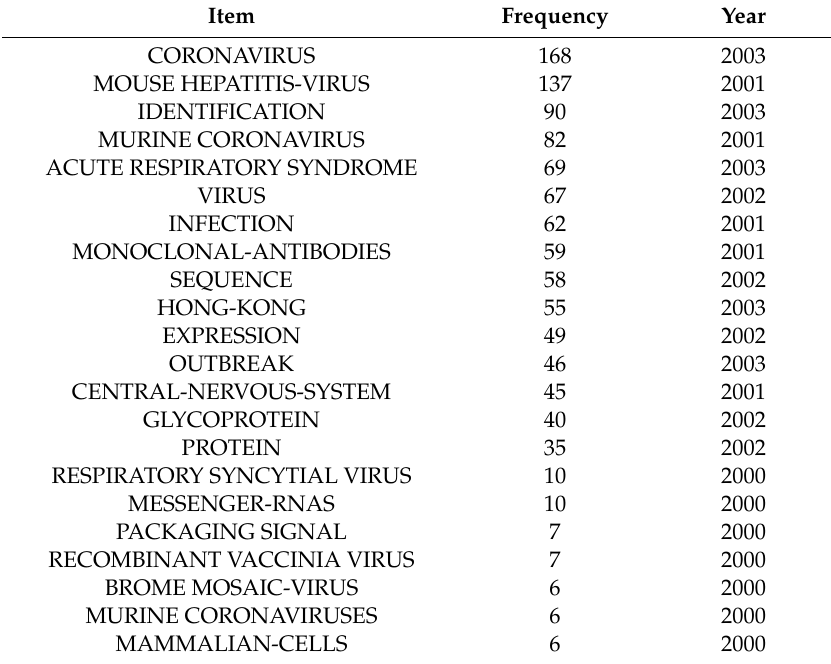
Figure 1. Keywords Cloud Map of 2000–2003. Table 2. Items and frequency of hot keywords between 2000 – 2003.